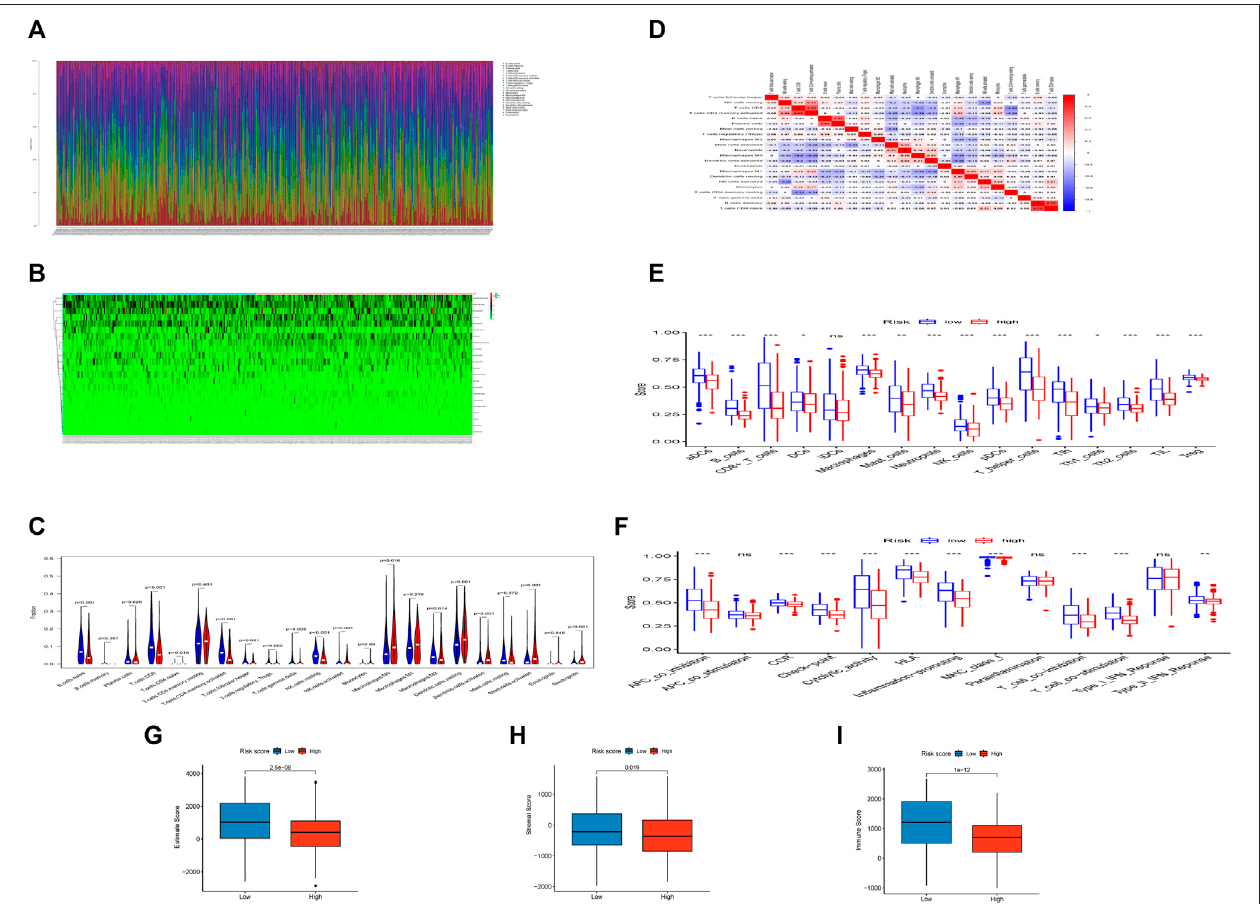
FIGURE 5 | The landscape of the TIME cells in HNSCC and the characteristics of different groups. (A) . The proportions of TIME cells of HNSCC patients in CIBERSORT. (B) . Heatmap of TIME cells in different subgroups. (C) . Violin diagram showing the immune cell composition of different groups in CIBERSORT. (D) . Correlation of different immune cells in HNSCC. (E) . The proportions of TIME cells of different groups in ssGSEA. (F) . The function of TIME cells of different groups in ssGSEA. (G) .Boxplotshowingdifferencesamongdifferentgroupsinestimatescore. (H) .Boxplotshowingdifferencesamongdifferentgroupsinthestromalscore. (I) . Boxplot showing differences among different groups in the immune